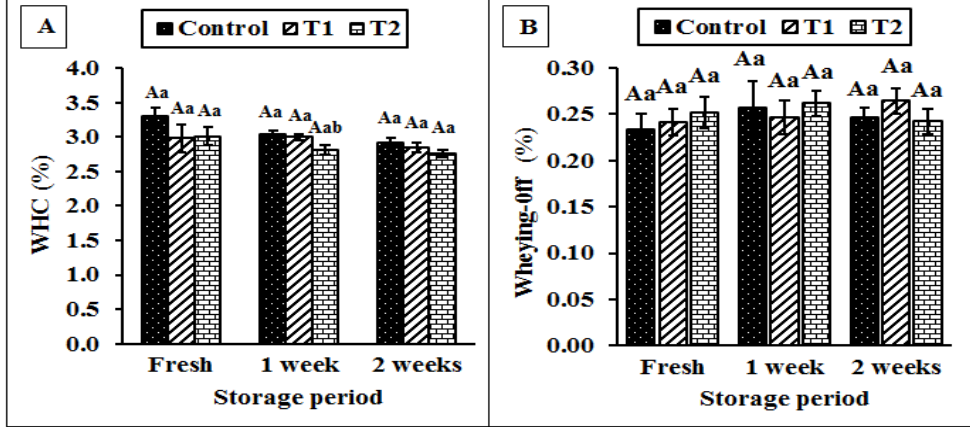
Figure 8. Effect of adding different concentrations of chromium (CrPic) on the wheying-off (%) ( A ) and water holding capacity (%) ( B ) of yoghurt during storage. Control: without Cr (CrPi), T1: with 0.25 ppm Cr (CrPi), T2: fortified with 0.5 ppm Cr (CrPi). Data are shown as mean ± SE for three replicates. Means with different small letters are significantly different between the treatments ( p ≤ 0.05). Means with different capital letters significantly differ between the storage periods ( p ≤ 0.05).